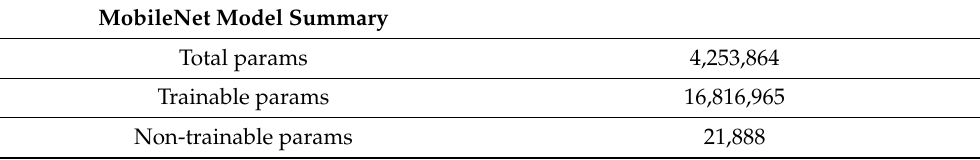
Table 3. MobileNet model summary.